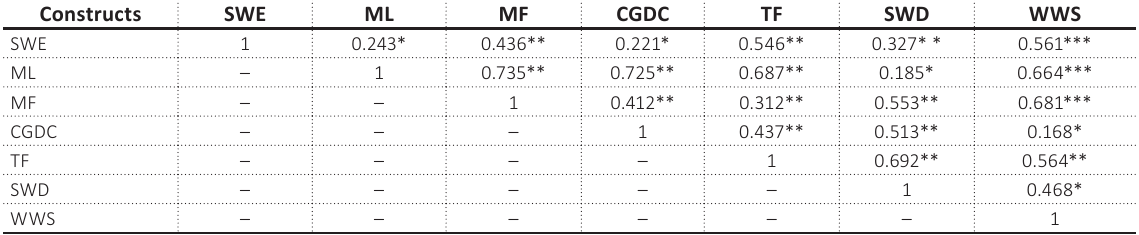
Table 3. Correlation matrix